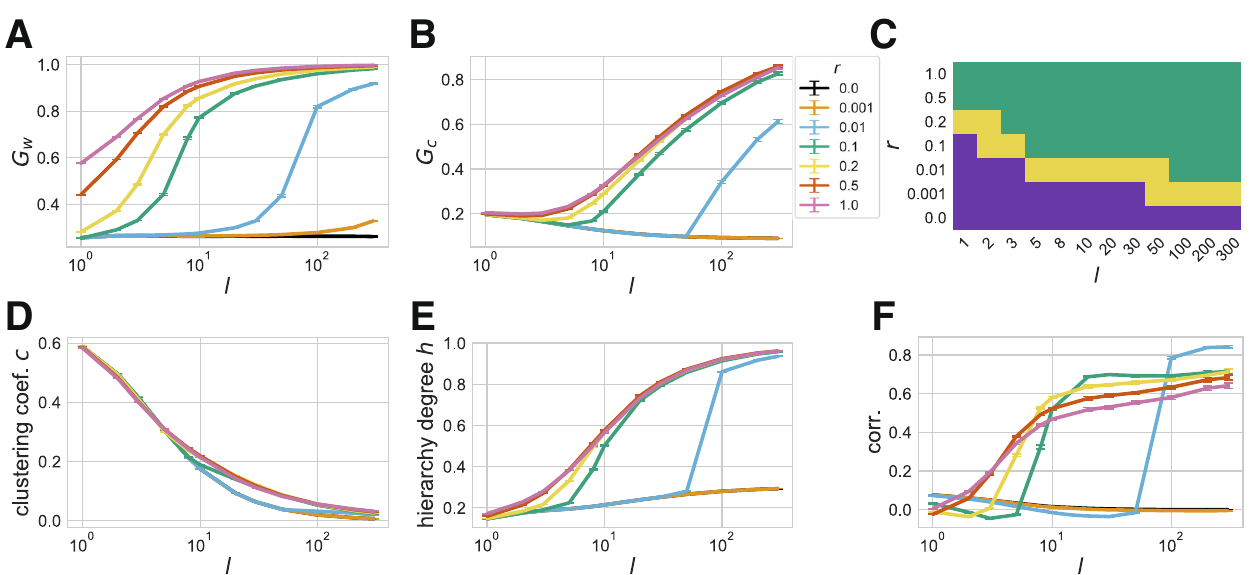
Fig. 3 Dependence of the disparities and network characteristics on interest rate r and the frequency of gifts l . Error bars show the standard deviations of 100 trials. A Gini coef fi cient for wealth G w . B Gini coef fi cient for connectivity G c . C Phase diagram of disparities. Phases of no disparities (purple), economic disparity alone (yellow), and economic and social disparities (green) are shown. D Average clustering coef fi cient c , that is, the cliquishness of a typical neighbourhood. E Flow hierarchy degree h , which is the persistent directionality in continuing fl ows. F The correlation coef fi cient of wealth and connectivity. Different line colours correspond to different interest rates r